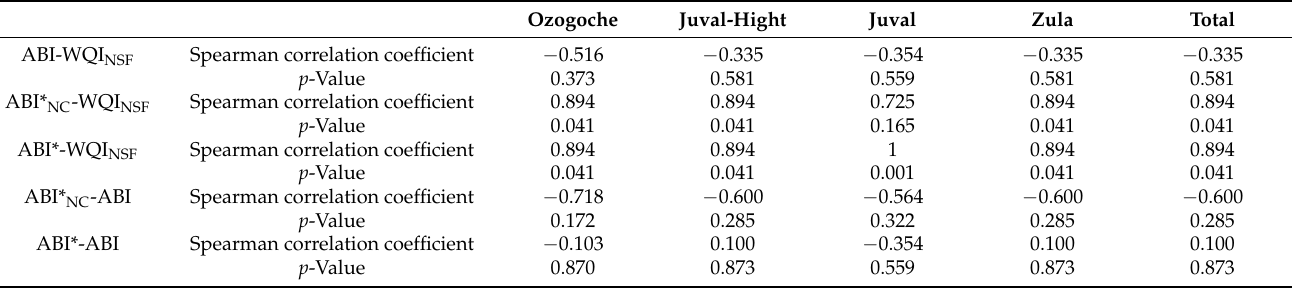
Table 9. Pairwise Spearman correlation between water quality indicator before and after calibration. Ozogoche Juval-Hight Juval Zula